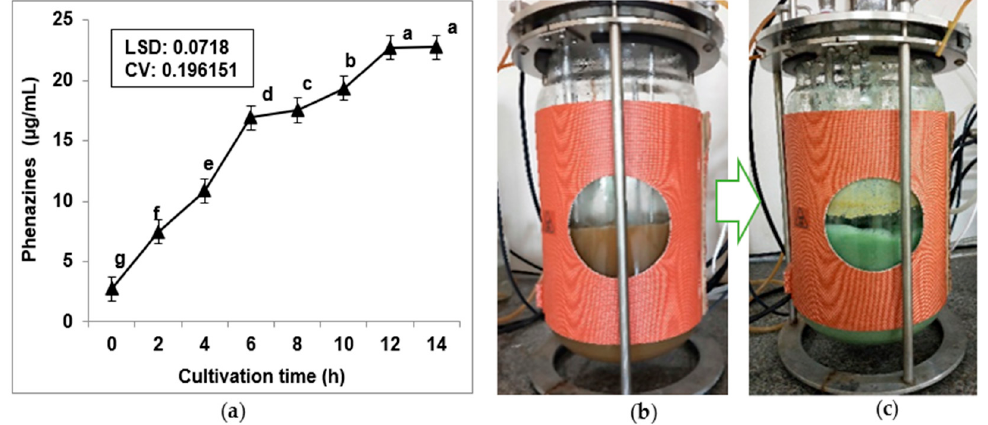
Figure 5. Scale-up production of phenazines by Pseudomonas aeruginosa TUN03 using a 14 L Bioreactor system. The recorded data of phenazine yield produced during the process of fermentation ( a ). The reaction tube of the 14 L Bioreactor system at 0 h ( b ) and 12 h ( c ) of fermentation. The 4.5 L of medium contained 1% SPP, 0.05% MgSO 4 , and 0.1% Ca 3 (PO 4 ) 2 mixed with 500 mL of bacteria seeds. The condition parameters for fermentation were set up with a shaking speed of 250 rpm, culture temperature at 30 °C, a dissolved oxygen content of 1.2 vvm, and a fermentation period of 14 h. The phenazine yield was determined per 2 h.